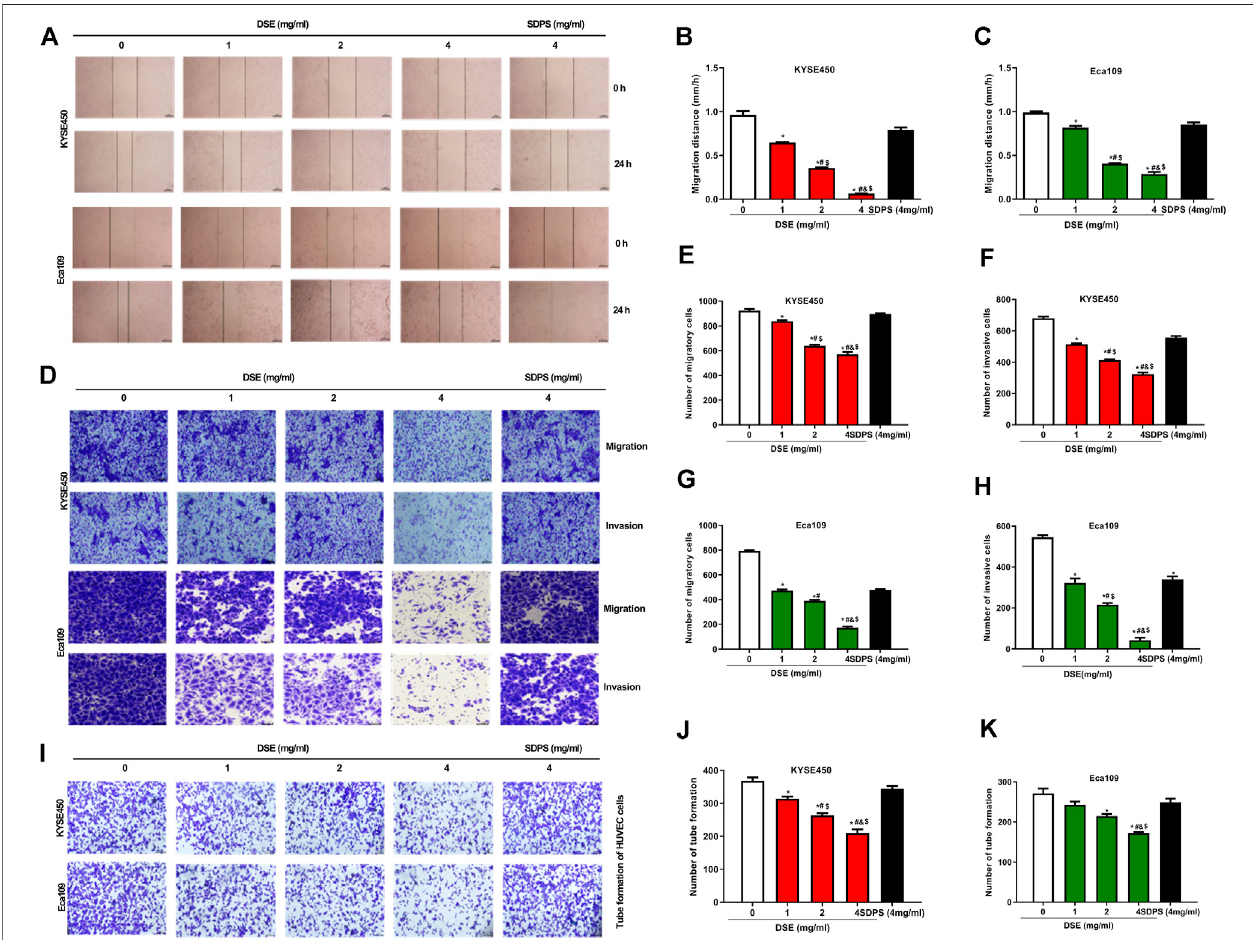
FIGURE 4 | DSE inhibits migration, invasion and angiogenesis in human ESCC cells. (A – C) Would healing was performed to detect the effects of DSE on cell migration in KYSE450 and Eca109 cells. Representative images were taken. Scale bars, 500 µm. (D – H) Transwell assay was performed to detect the effects of DSE on cell migration and invasion in KYSE450 and Eca109 cells. Representative imageswere taken. Scale bars, 100 µm. (I – K) Tubeformation assay was performed to detect the effects of DSE on angiogenesis induced by KYSE450 and Eca109 cells. Representative images were taken. Scale bars, 100 µm. All data are expressed as mean ± standard deviation ( n = 3). * p < 0.05 vs. 0 mg/ml DSE group. # p < 0.05 vs. 1 mg/ml DSE group. & p < 0.05 vs. 2 mg/ml group. $ p < 0.05 vs. positive control SDPS group.